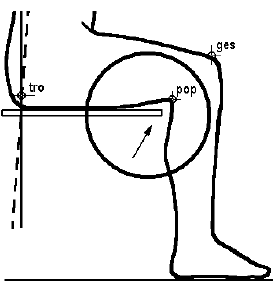
Figure 2. Individual adjustment of the chair’s seat height above the floor and the lower limb support to the height of the desk surface (Decree 542/2007 of the Ministry of Health of the Slovak Republic) [9]. A free space for the lower limbs with a minimal width and depth of 50 cm and a minimal height of 60 cm above the floor, or lower limb support (in which the optimal width and depth of the space for lower limbs is 70 cm or more) is required for a sitting work in the neutral position of the employee to the table (forward inclination of the torso axis 4 ◦ ) is equal to the difference in height of the upper surface of the table from the floor and